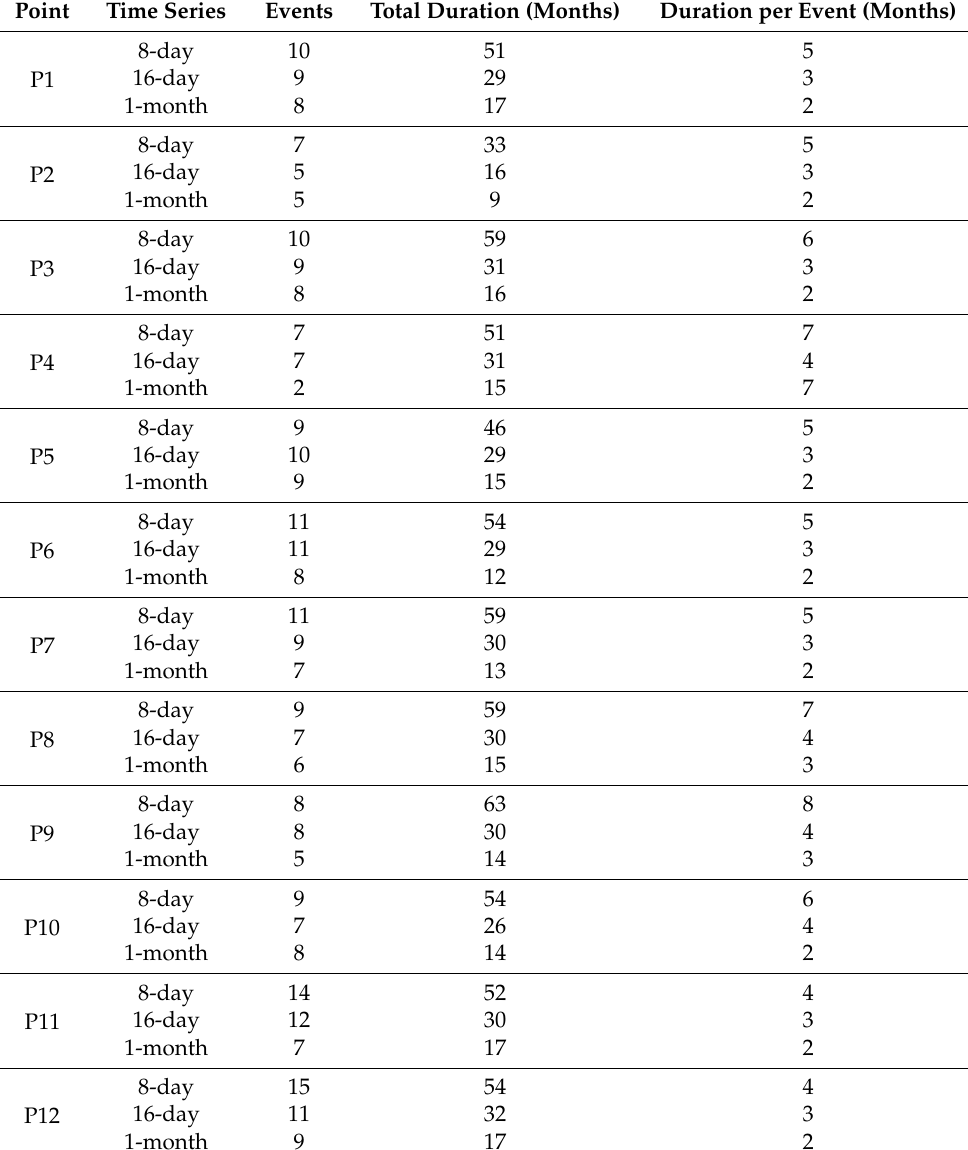
Table 3. Drought events, total drought durations, and duration per event at points P1 to P12 at 8-day, 16-day, and 1-month temporal scales in the Ruvu River